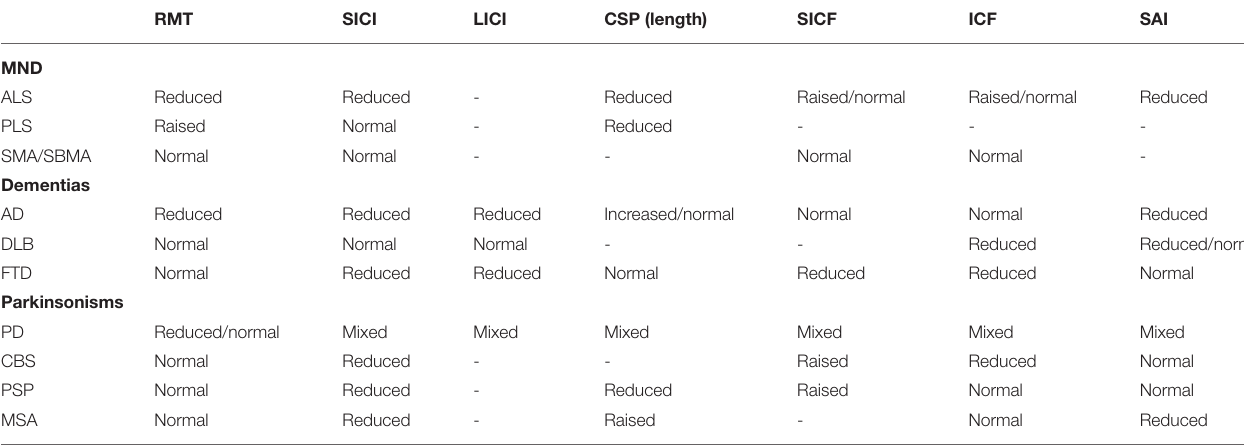
TABLE 1 | Summary of corticospinal changes stratified by neurodegenerative